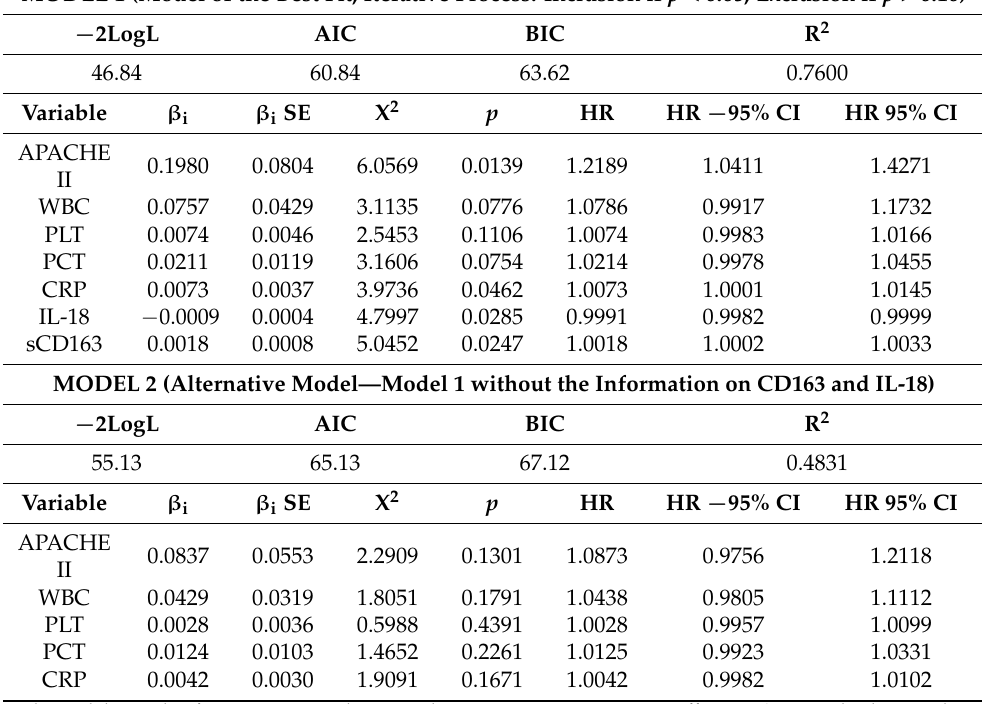
Table 6. Cox proportional hazards regression